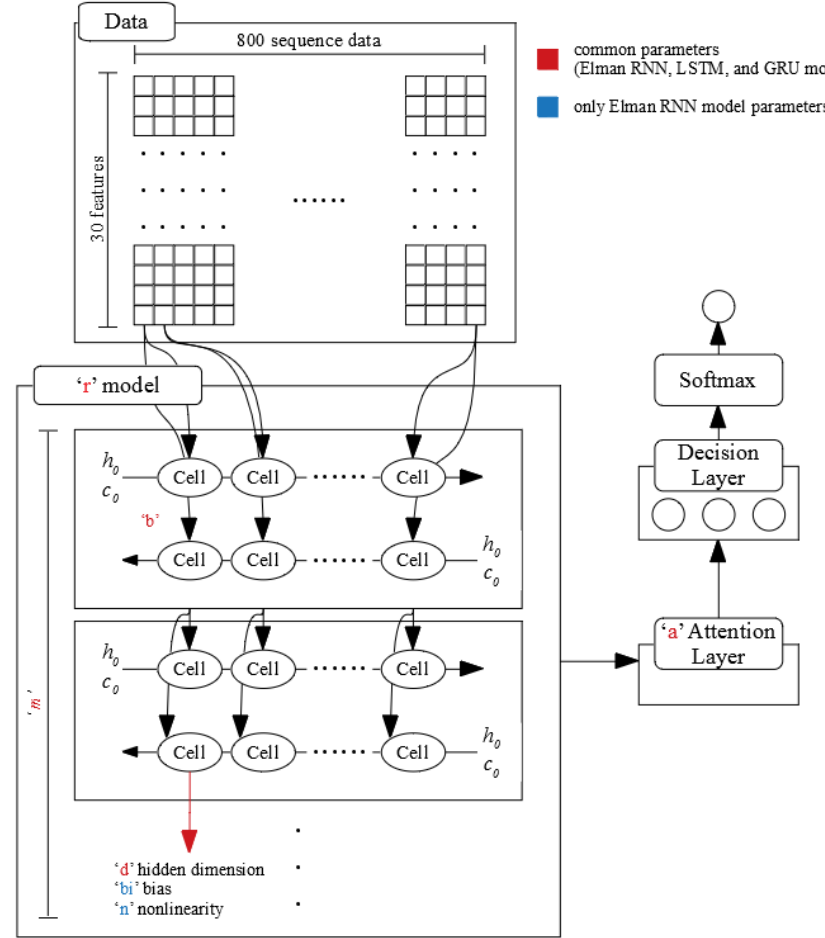
Figure 7. RNN model